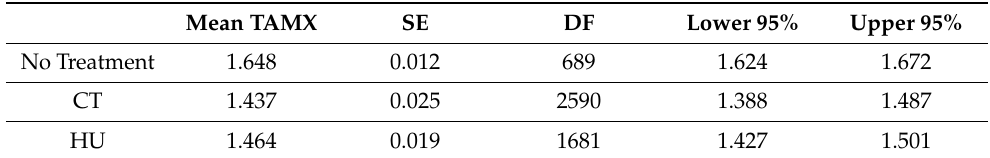
Table 3. Mean MCA TAMX velocities—controlled for age. Least squares means estimates for the three treatment groups, factoring in age effects as a covariate for analyzing the TCD results. The 95% confidence intervals between no treatment and HU do not overlap, demonstrating a statistically significant difference between treatment groups. The results from this table are graphically depicted in Figure 3,